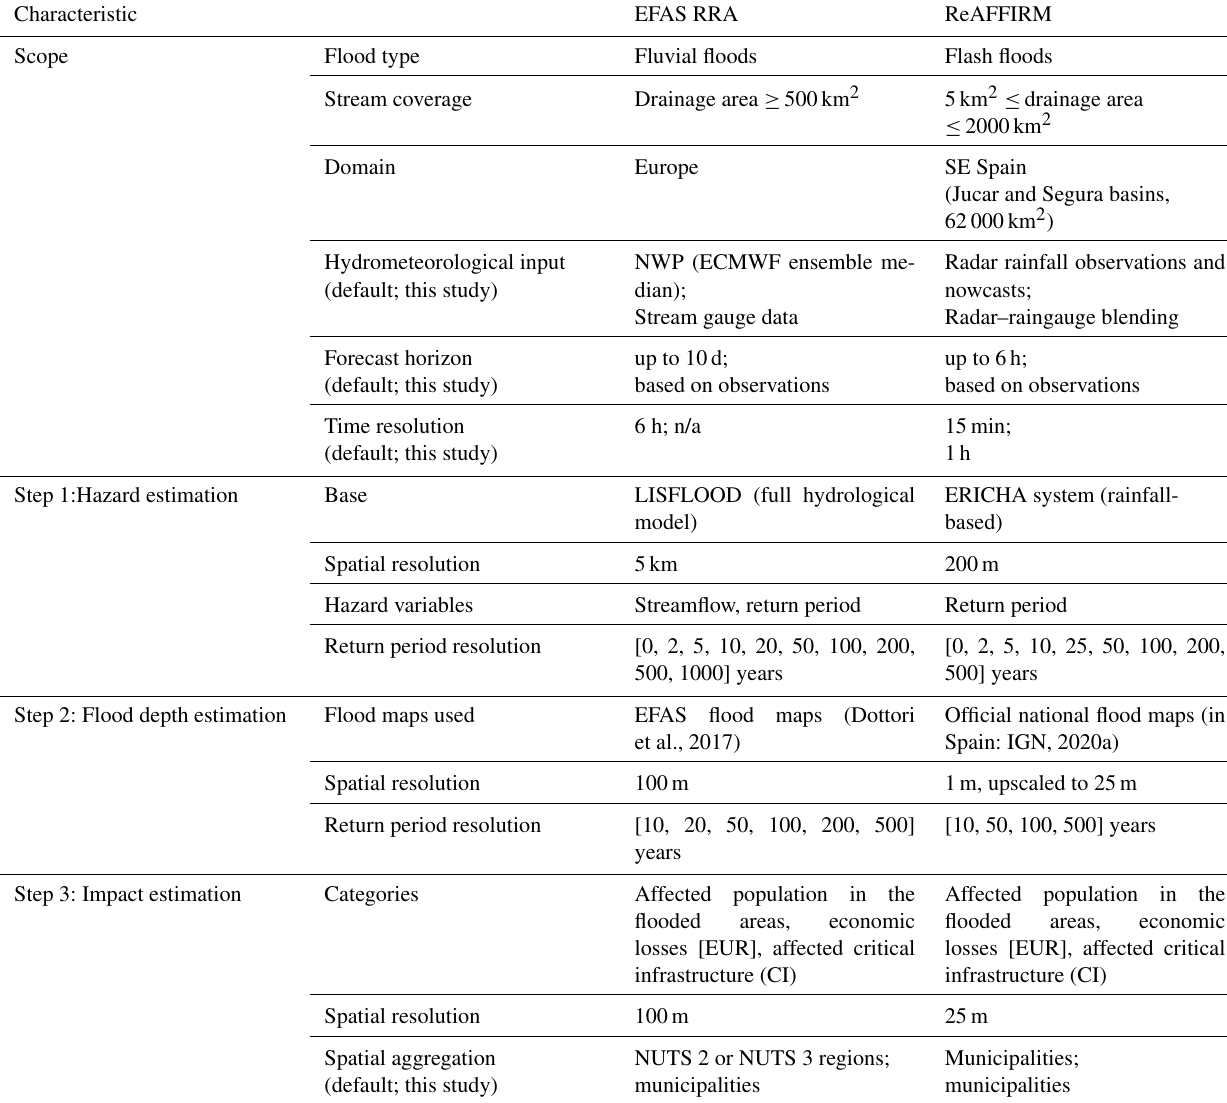
Table 1. Characteristics of the employed methods for assessing fluvial (EFAS RRA) and flash flood impacts (ReAFFIRM). Note that n/a stands for not